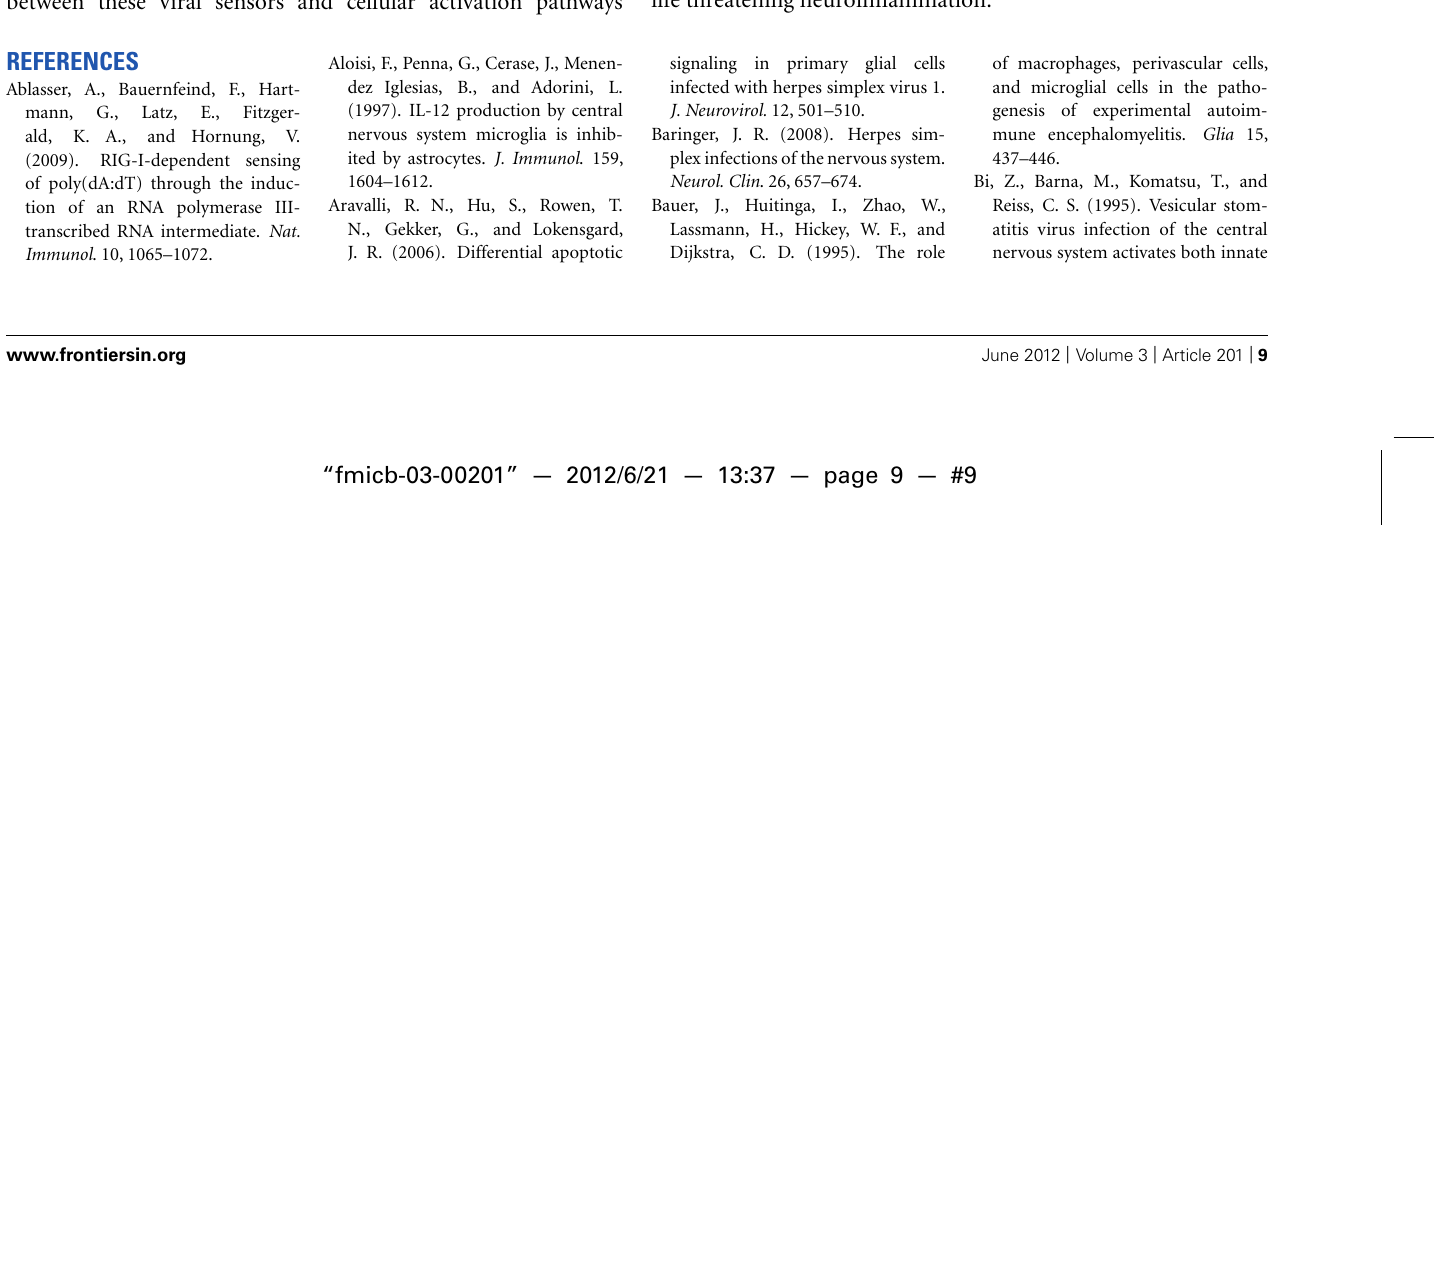
including interferon promoter stimulator (IPS)-1 and stimulator of interferon genes (STING), leading to the activation of the transcription factors NF- κ B and interferon-regulatory factor (IRF) 3, which translocate into the nucleus and initiate anti-viral and inflammatory cytokine production. In addition, the activity of RNA polymerase III (Pol III) could provide an additional mechanism for the perception of DNA viruses via